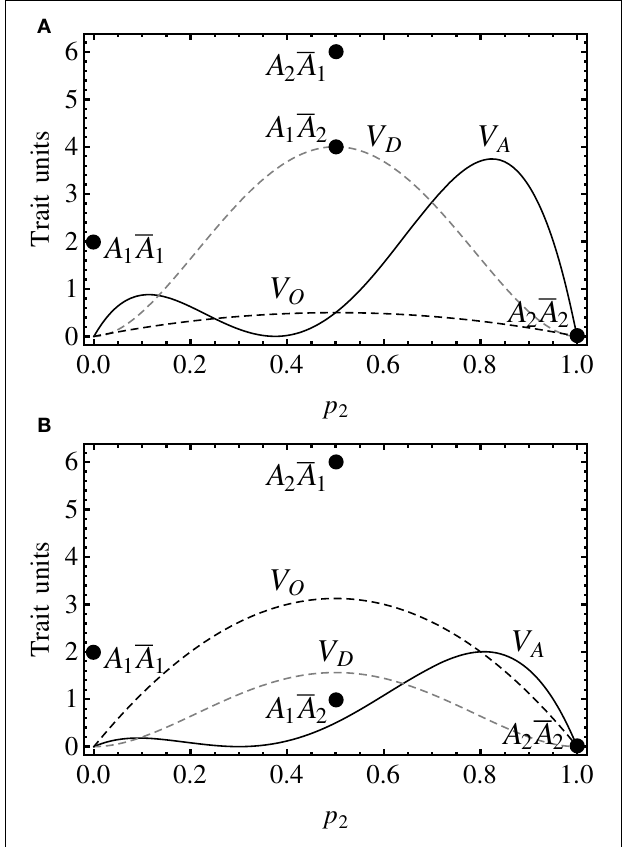
FIGURE 3 | Genotypic values (discs) and variance decomposition (curves) of one-locus, two-allele, imprinted genetic systems assuming Hardy–Weinberg proportions. The notation is in accordance with the previous figures (with the addition of a black dashed curve for the imprinting variance). (A) The genotypic values are G 11 = 2, G 12 = 4, G 21 = 6, G 22 = 0, leading to individual-referenced genetic effects (from the reference of A 1 ¯ A 1 ) a = − 1, d = 4, i = − 1. Since the additive and the dominance effects are the same as in Figure 1B , the additive and the dominance variances coincide and the equilibrium point also remains at p 2 = 0 . 375. (B) The genotypic values are the same as in (A) but for G 21 = 1 (at the midpoint between the two homozygotes), leading to individual referenced genetic effects of a = − 1, d = 2 . 5, i = − 2 . 5. The equilibrium point occurs here at p 2 = 0 .